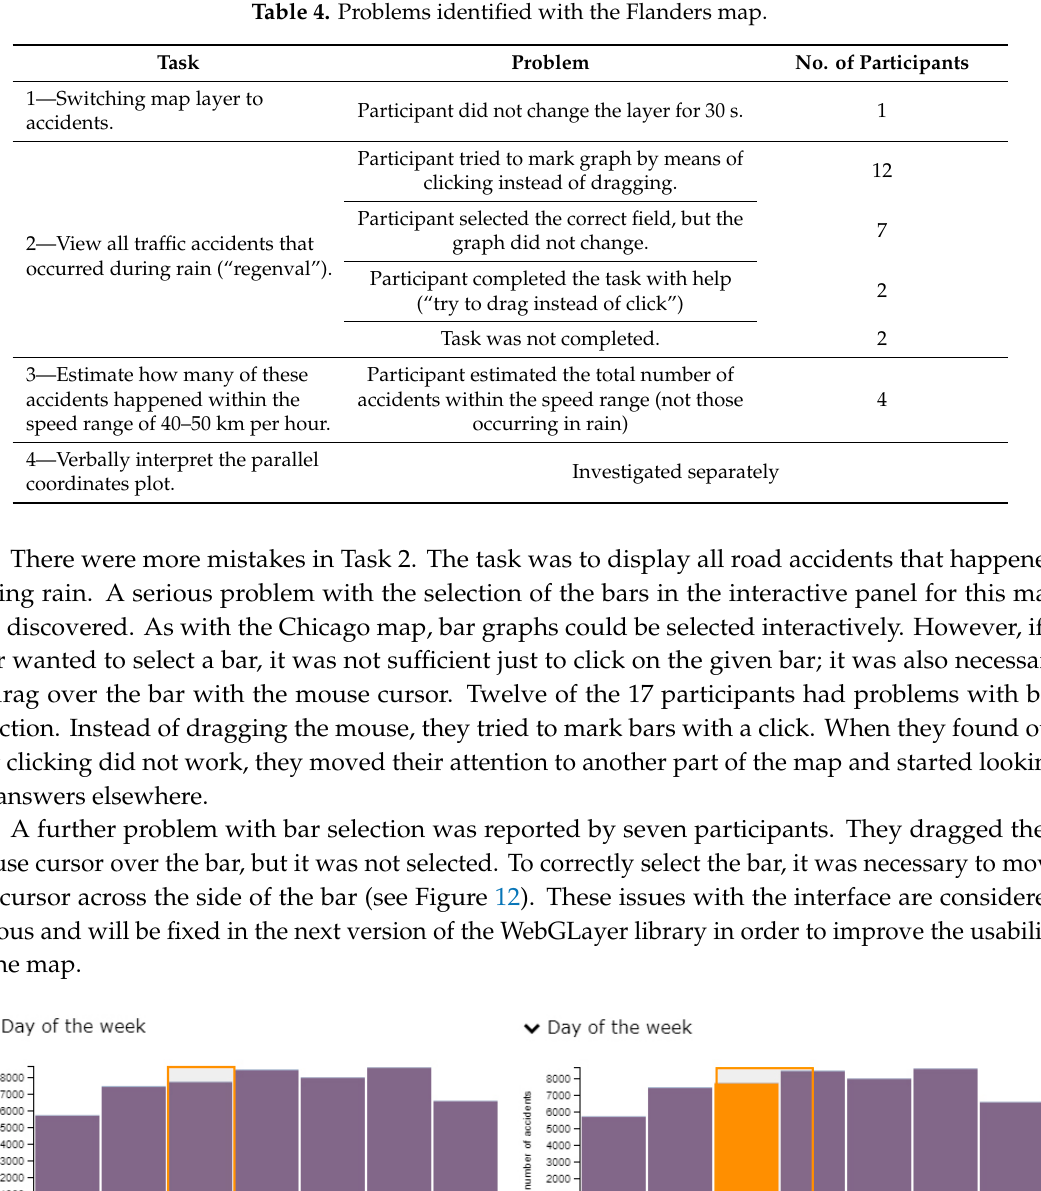
Figure 13. Problematic Task 2 in Flanders map. The last task of the whole experiment was to verbally interpret the parallel coordinates feature. None of the participants were able to describe the functionality of this feature. Most of the participants complained about a confusing design, a small and illegible font, and poorly chosen colors that disappeared against a black background. The feature itself was not accompanied by any